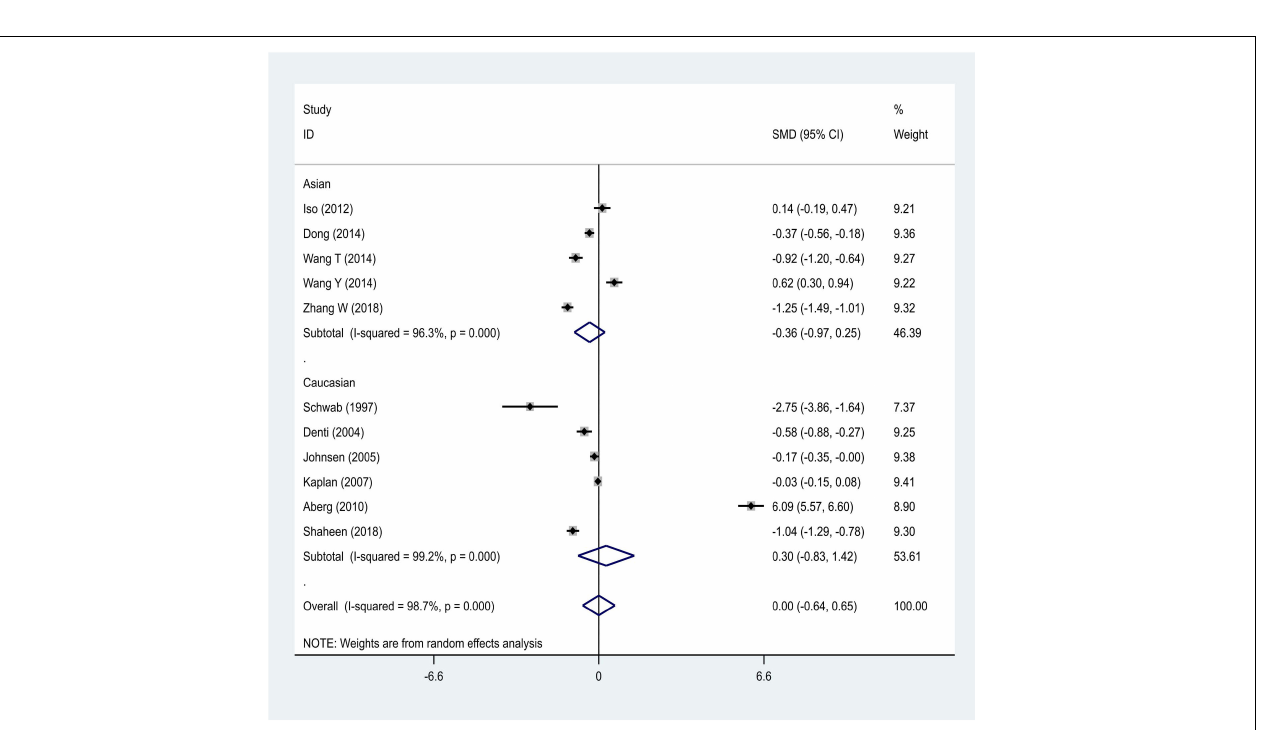
FIGURE 8 | Results of meta-analysis for the level of IGF-1 in the Asian and Caucasian populations, respectively.